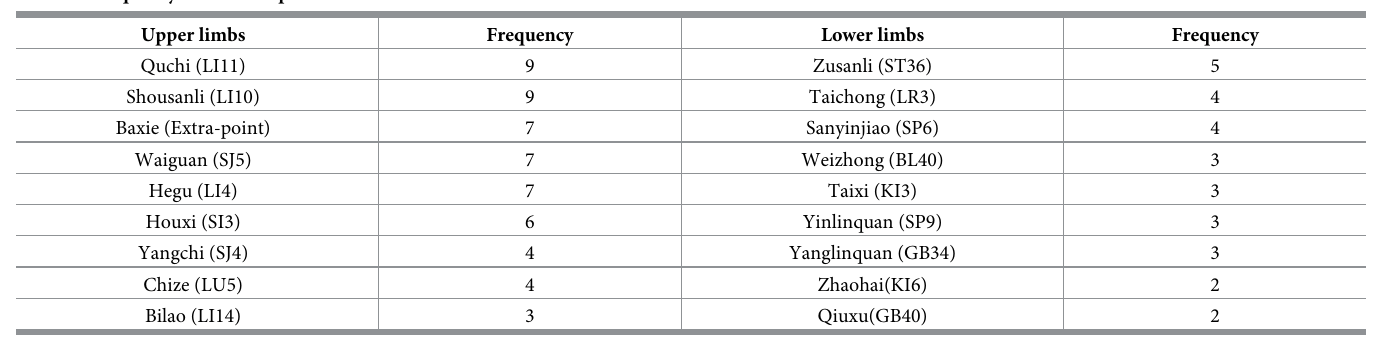
Table 3. Frequency of main acupoints.